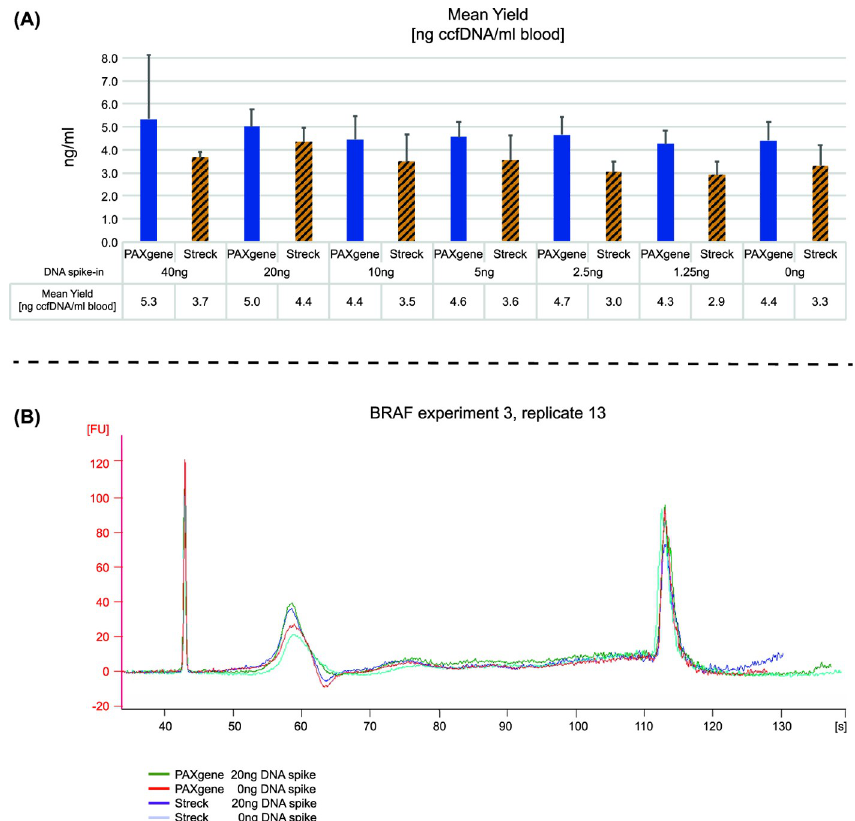
Fig 2. Quality control: CcfDNA yield and fragment distribution. (A) Qubit 1x dsDNA HS Assay-Kit. (B) Exemplary Bioanalyzer electropherograms. A 2100 Bioanalyzer instrument and the associated High Sensitivity DNA Kit were used. FU stands for fluorescence units and s for seconds run